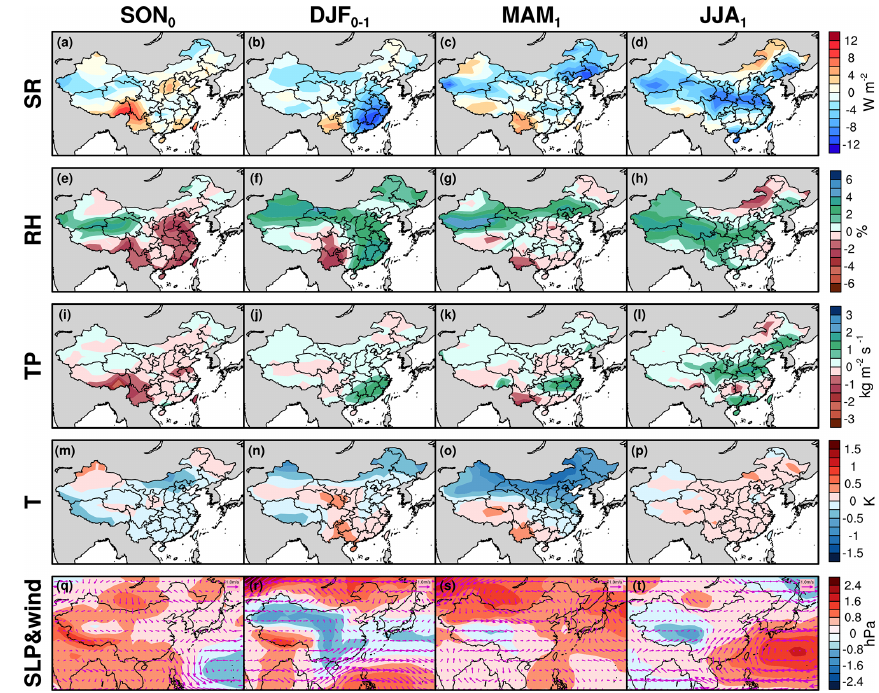
Figure 4. Same as Fig. 3 except for CP El